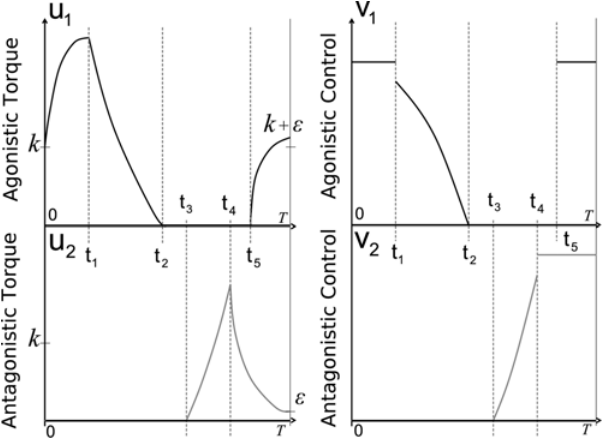
Figure 12. Optimal Triphasic Pattern. Illustration of the optimal behavior of a 1-dof arm, under the small angles assumption and with a pair of agonistic and antagonistic muscles, modeled by first-order dynamics. The subscripts 1 and 2 denote the flexor and extensor muscles, respectively. The triphasic pattern is an agonistic burst, followed by an antagonistic burst, and again an agonistic burst. The inactivation occurs between the first agonistic and antagonistic bursts. The times t i denote the commutation times. The left graphs illustrates the behavior of the angular torques ( u ). The right graphs illustrate the behavior of the control signals ( n ), that are the input signals for muscles contractions (i.e., the signals driven by motoneurons). All signals are plotted with respect to time t varying between 0 and T